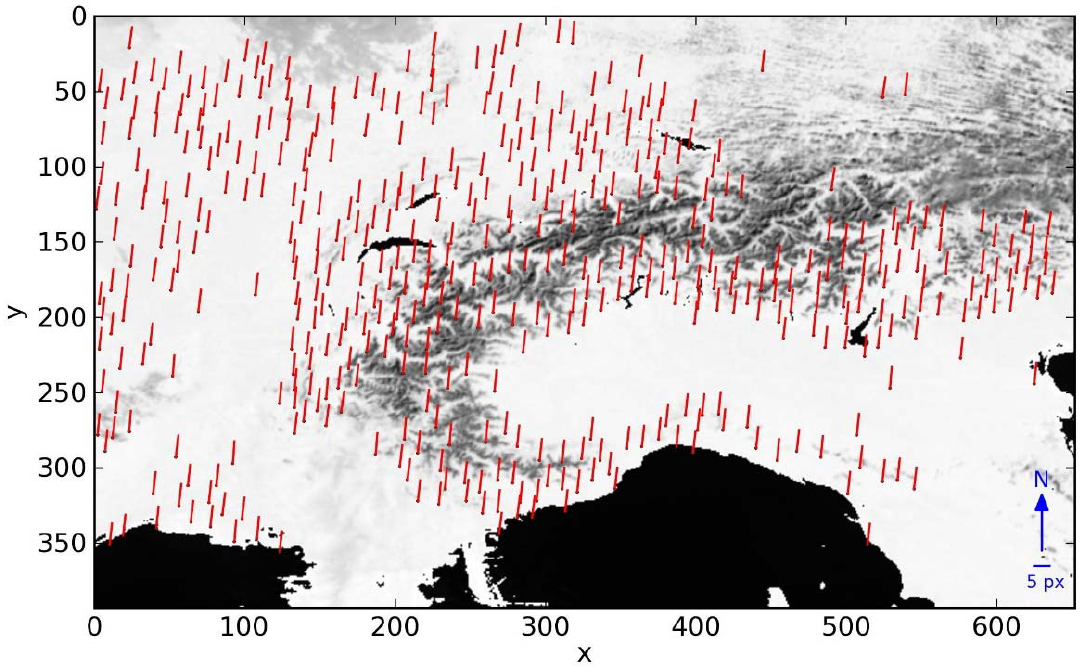
Figure 6. 2D image space residuals between the 10:30 and 10:45 images acquired on 7 February 2008. The scale for residual vectors is depicted in the lower right.